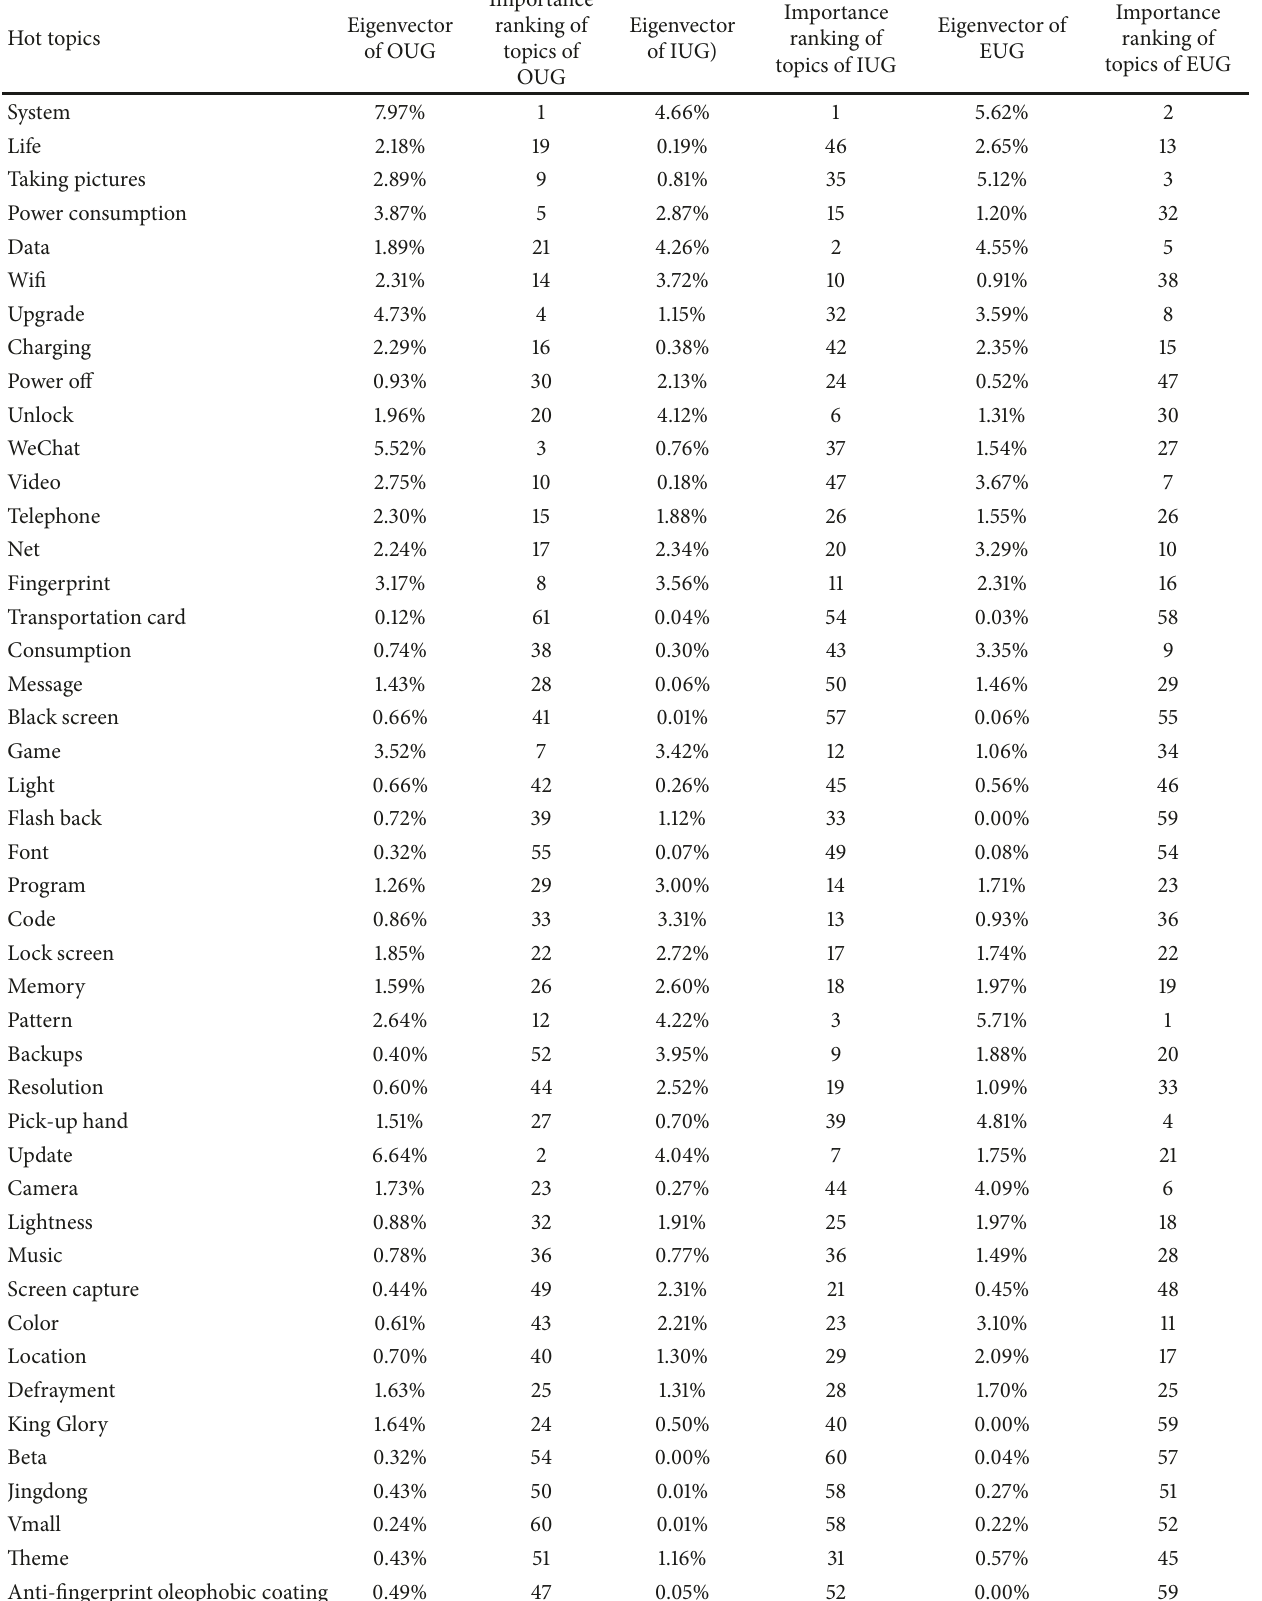
Table 10: The importance ranking and eigenvector corresponding to maximum eigenvalue of three